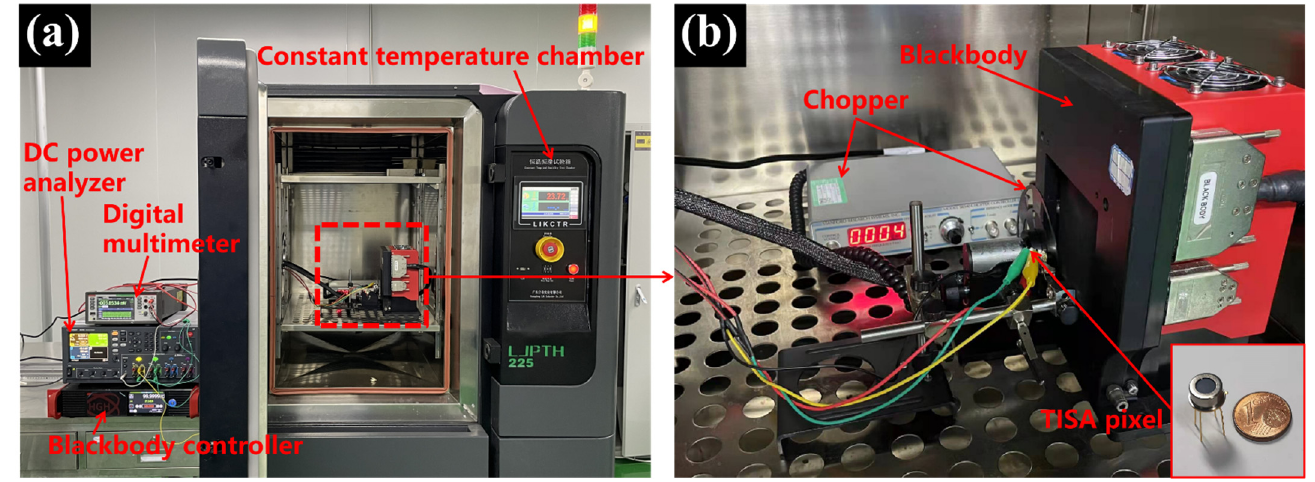
Figure 4. ( a ) The test system for a separate thermopile and a TISA pixel, ( b ) An Enlarged photograph at the blackbody position.